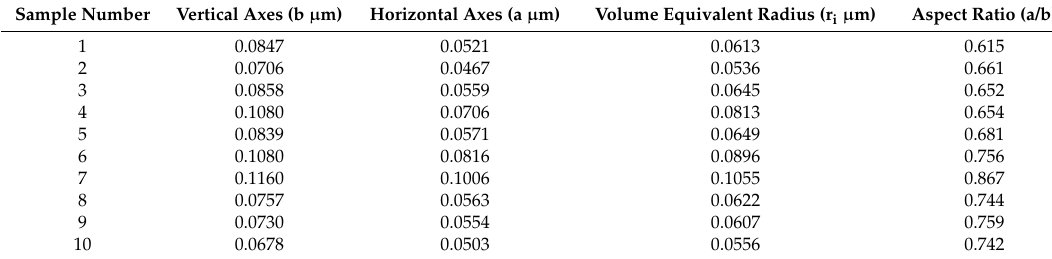
Figure 12. A SEM image of BB aerosol from white pine combustion in the furnace. Table 1. Input data from images of filter samples from tube furnace.